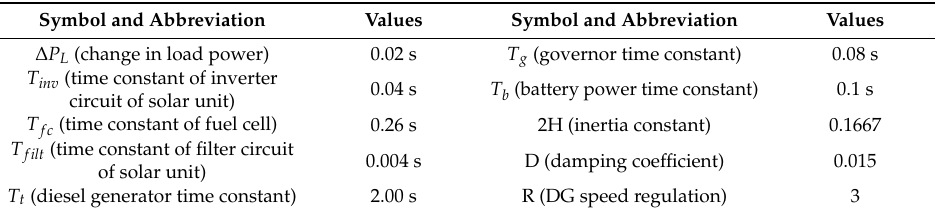
Table 1 describes the parameters of the MG equations utilized in the simulation. Table 1. The MG power system’s